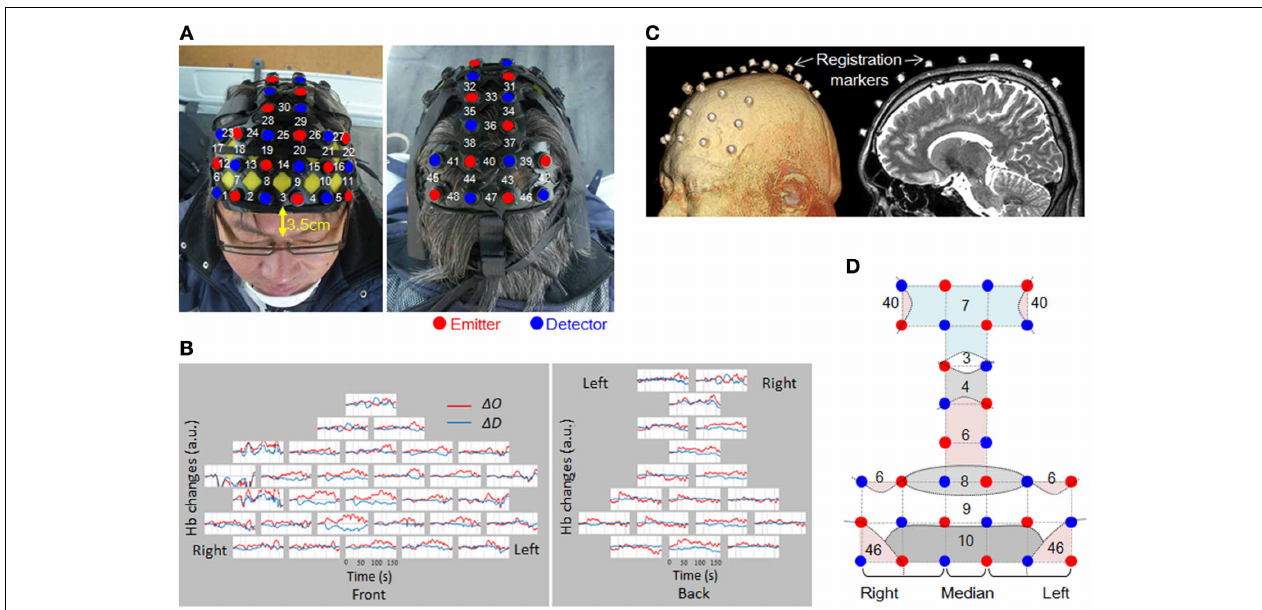
FIGURE 4 | Channel arrangement and location registration. (A) Attachment of probes, and channel numbers. (B) Raw data from a single trial for one subject. Channels are arranged as shown in (A) . (C) MRI was used to verify the probe mounting position. (D) Straight lines connecting emitters and